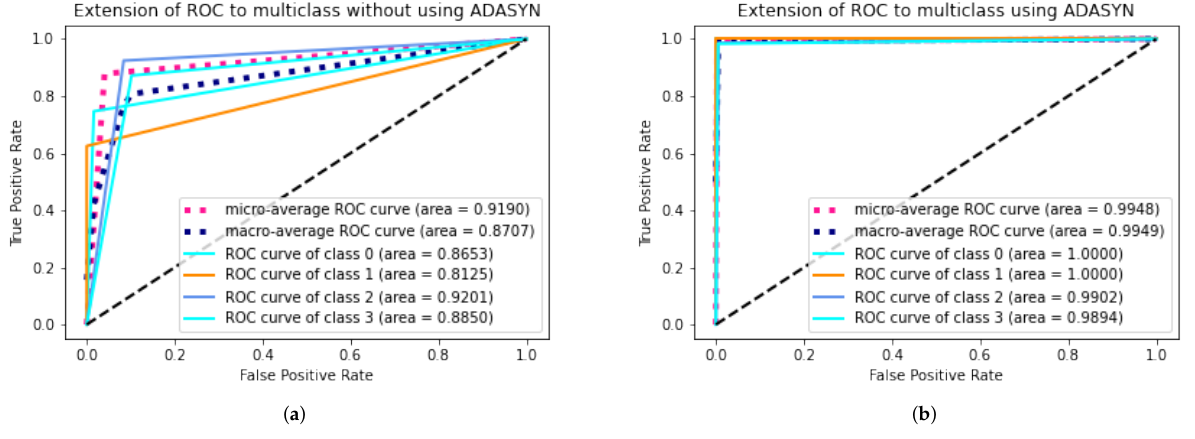
Figure 8. Self-comparison of Extension receiver of proposed DAD-Net With and without using ADASYN up-sampling algorithm. ( a ) Proposed DAD-Net without ADASYN; ( b ) Proposed DAD-Net with ADASYN.